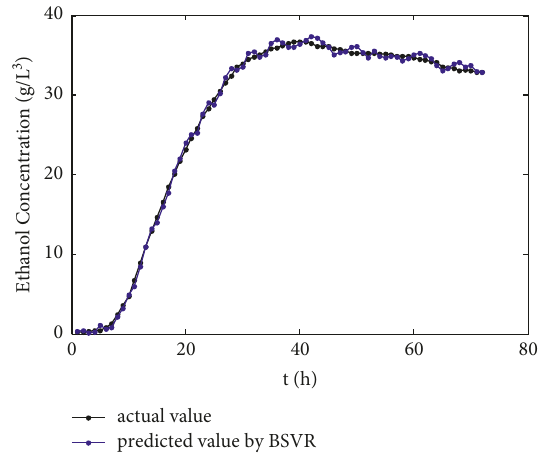
Figure 4: Comparison of ethanol concentrations based on BSVR and offline assay values.